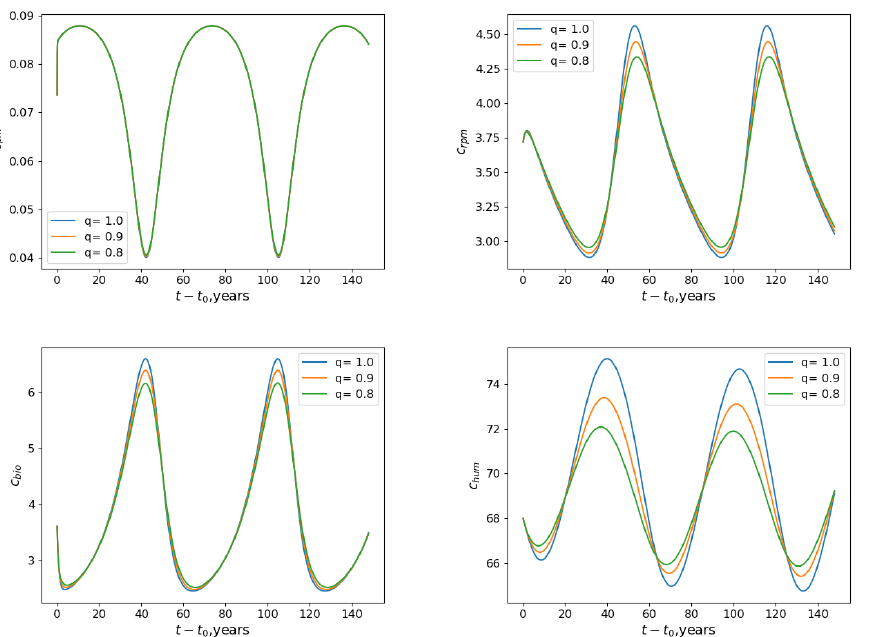
Figure 1. From the top-left cell following the left-to-right direction: the numerical solutions